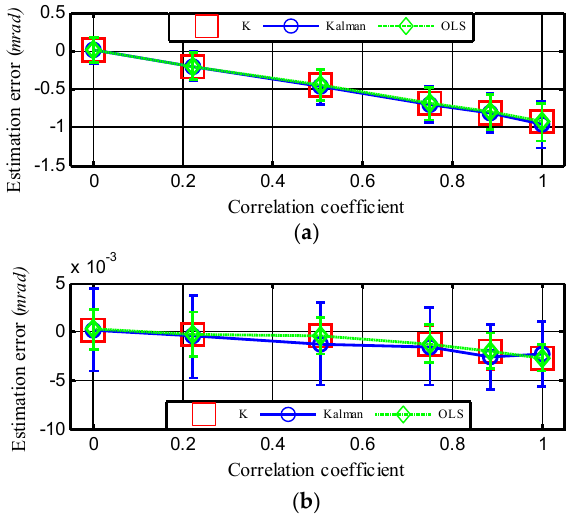
Figure 4. Bias error as a function of the correlation coefficient. ( a ) Error for the estimation of yawing angle. ( b ) Error for the estimation of pitching angle. The vertical lines indicate the corresponding standard deviations or error bars.